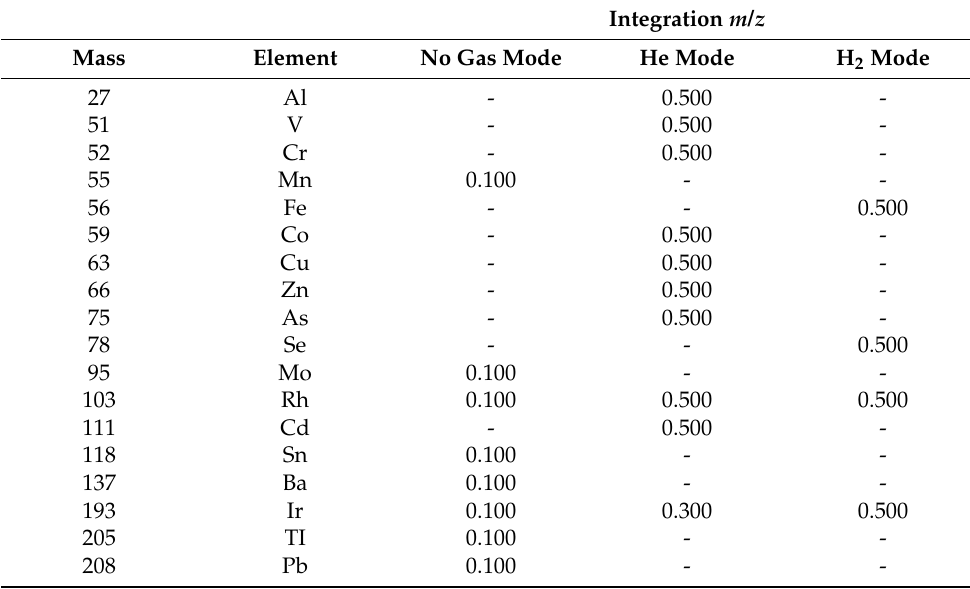
Table 3. ICP-MS system acquisition